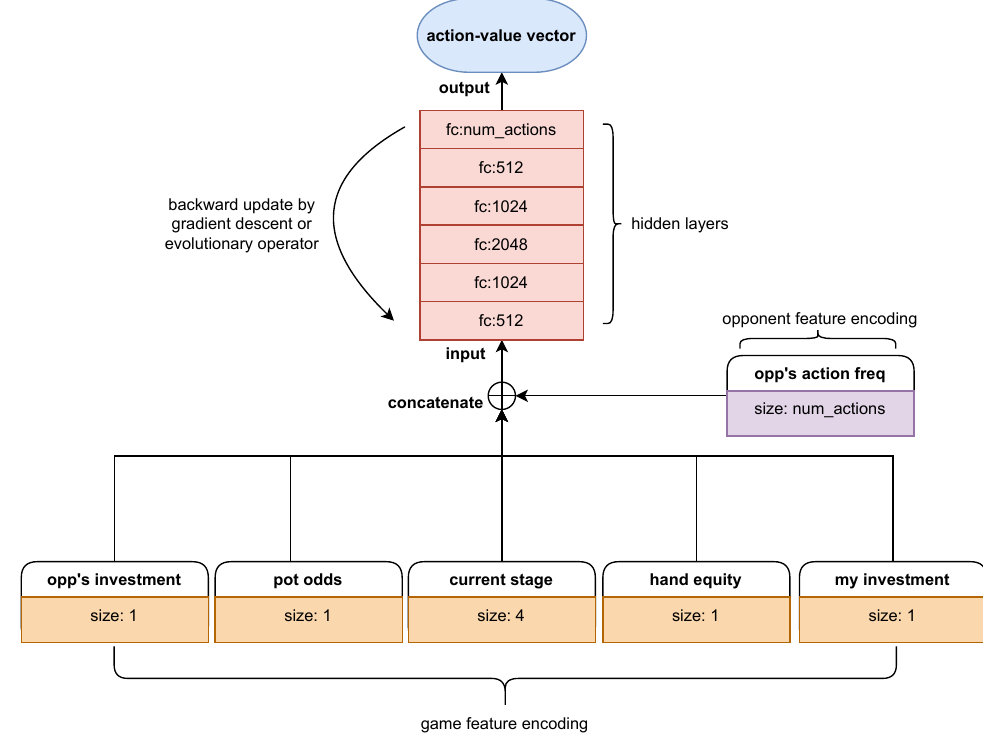
Figure 2. Arc_pro, a prototype architecture for the NE and RL agents. It receives domain-specific inputs and transfers to output action values with several layers of full-connected (fc) neural